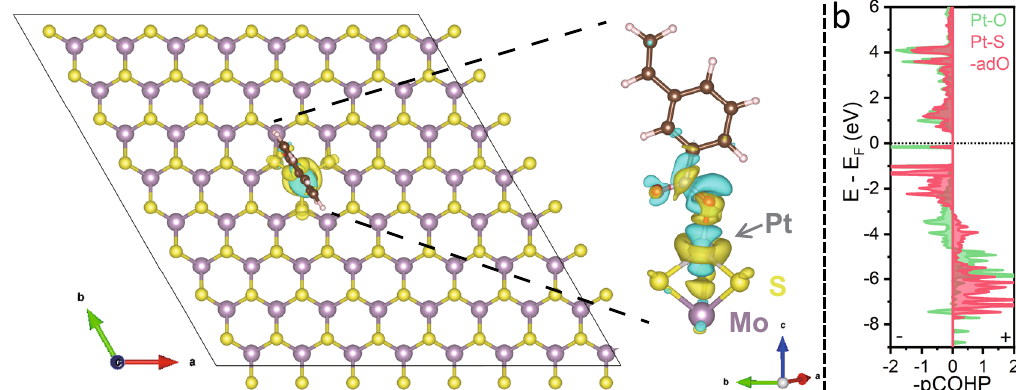
Fig. 6 DFT calculations. a Differential charge density of the optimized “ end-on ” con fi guration of 3-nitrostyrene on Pt SAC at the Mo atop site, showing electron accumulation (yellow) and depletion (cyan) regions. The color scheme used: purple for Mo, yellow for S, white-grey for Pt, red for O, light-blue for N, brown for C and white-pink for H; b The -pCOHP curves for 3-nitrostyrene adsorption on Pt SAC at the Mo atop site (green: Pt-O bond; red: nearby Pt-S bond, denoted as